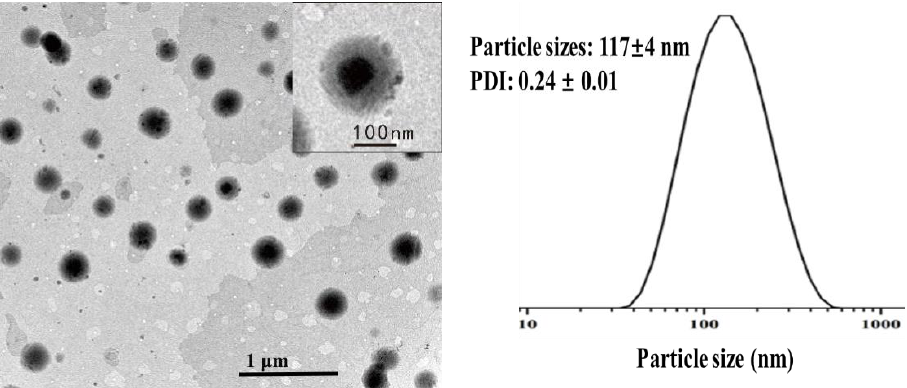
Figure 5. Transmission electron microscopy image of α -TOC-NaOl/RebA complex with 30% loading of α -TOC.